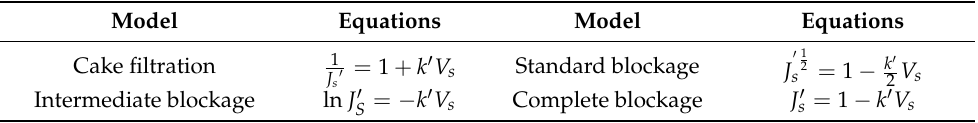
Table 1. The equations of the Hermia model: J (cid:48) s = p 0 / p , p represented the TMP data at a given time (kPa), p 0 represented the initial TMP data when the filtration begins (kPa), Vs was the cumulative filtrate volume and k (cid:48) was the model constant.